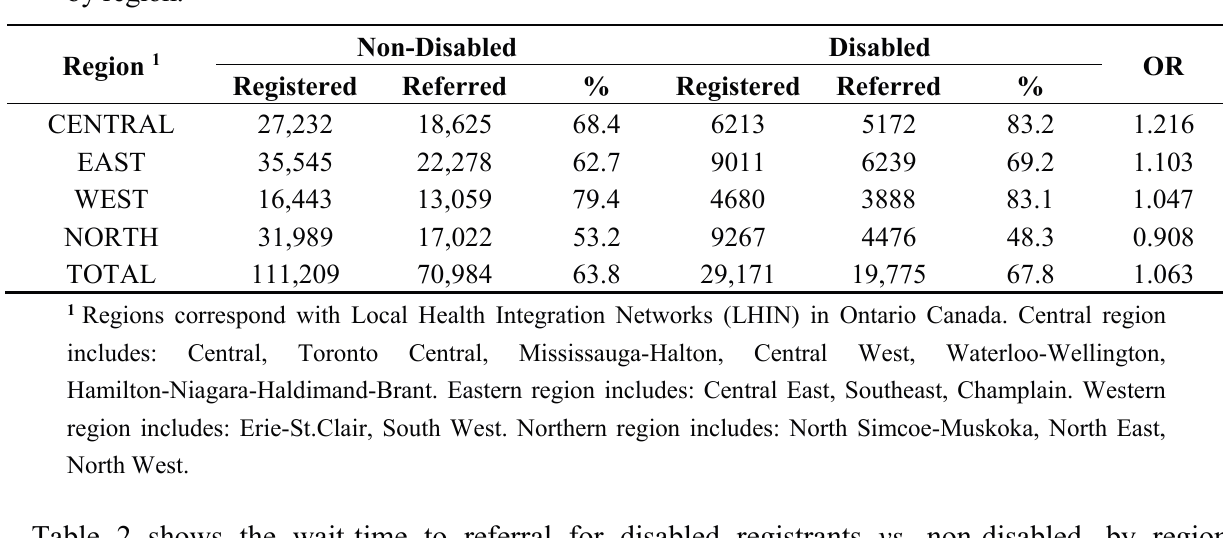
Table 1. Success rates in linking non-disabled and disabled registrants with family physicians by